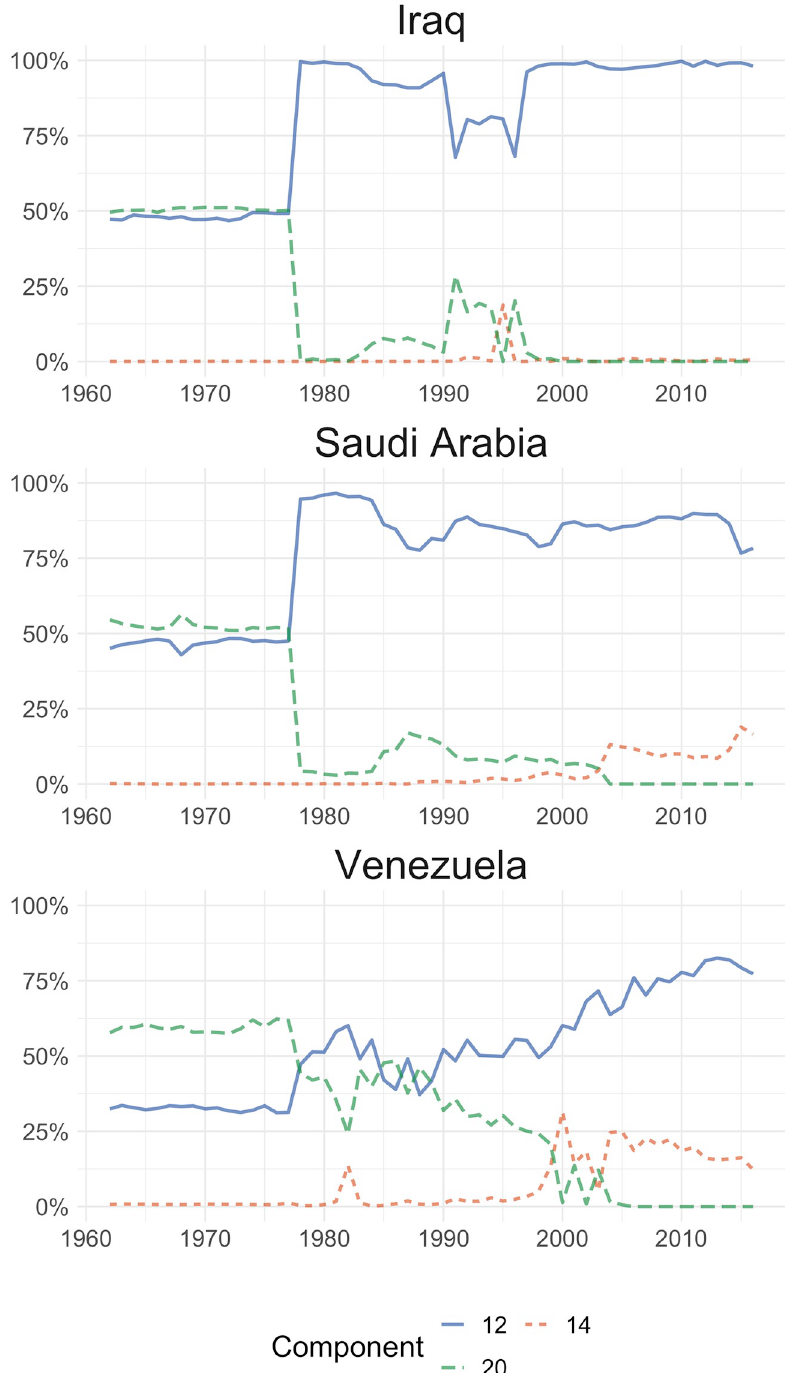
Fig 3. LDA outputs for Iraq, Saudi Arabia and Venezuela. Distribution of the top three components by country. 12: Crude petroleum; 14: Lubricating petroleum oils and preparations; 20: Fuel oil, gas-oil.